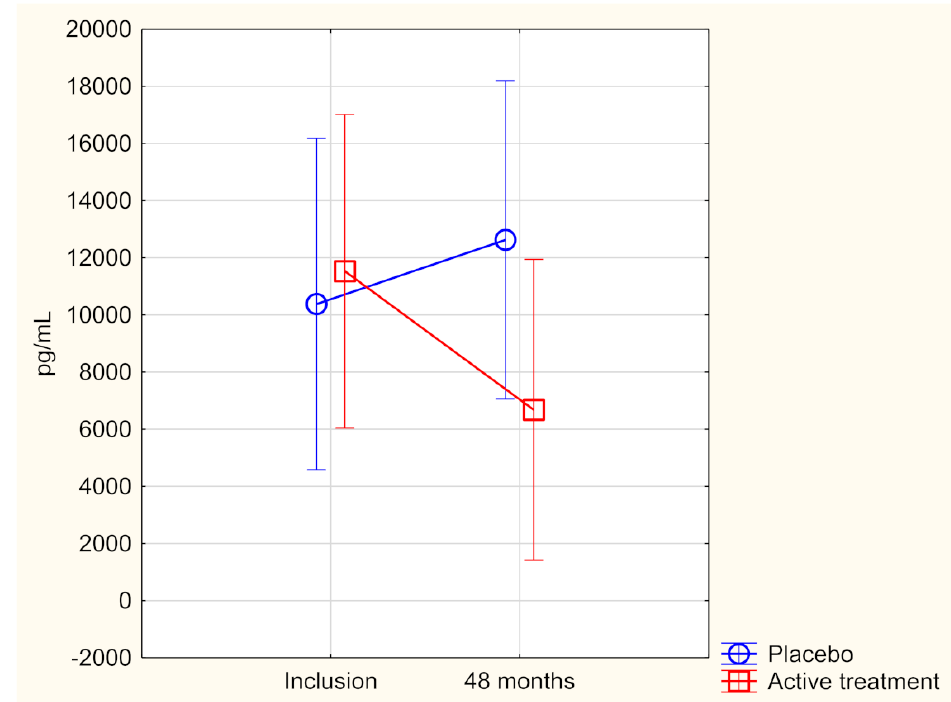
Figure 1. Concentration of FGF-23 at the start of the project and after 48 months in the selenium and coenzyme Q 10 treatment group compared to the placebo group in the study population. Evaluation performed by use of repeated measures of variance methodology Current effect: (F(1,193)= 6.60; p = 0.011). Vertical bars denote 0.95 confidence intervals. Blue curve: placebo; red curve: active treatment